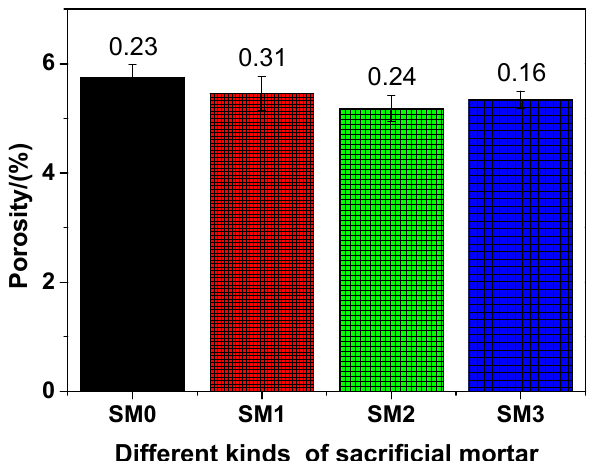
Figure 9. The porosity of different kinds of siliceous sacrificial mortar at curing time of 28 days.